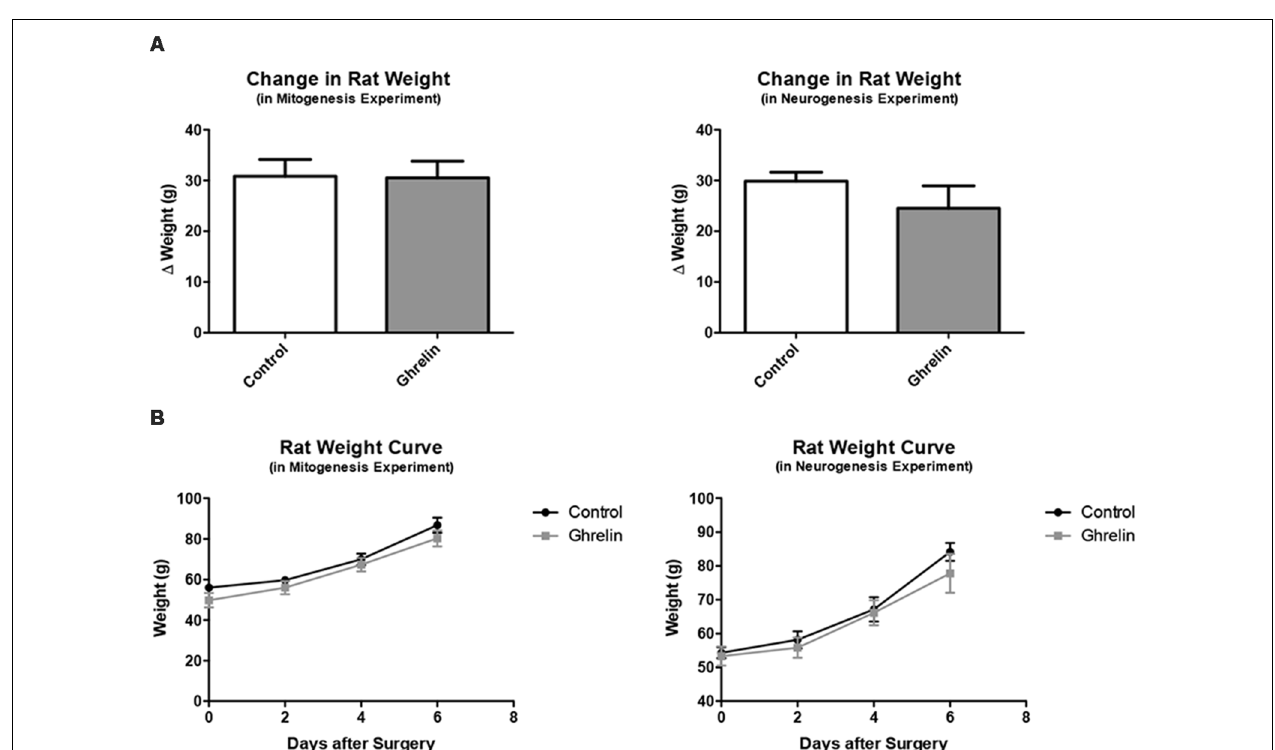
FIGURE 5 | Rat weights for mitogenesis experiment. (A) For the mitogenesis and neurogenesis experiments, we compared the change in weights from the day of surgery (PND 22) to 1 week following surgery (PND 29) for both the control ( n = 6) and ghrelin treated ( n = 6) groups (A) . Values are expressed as mean ± SEM ( p > 0.05). (B) We also compared the weights of control and ghrelin-treated groups every 2 days from the day of surgery to 1 week following surgery (two way repeated measures ANOVA, p > 0.05).